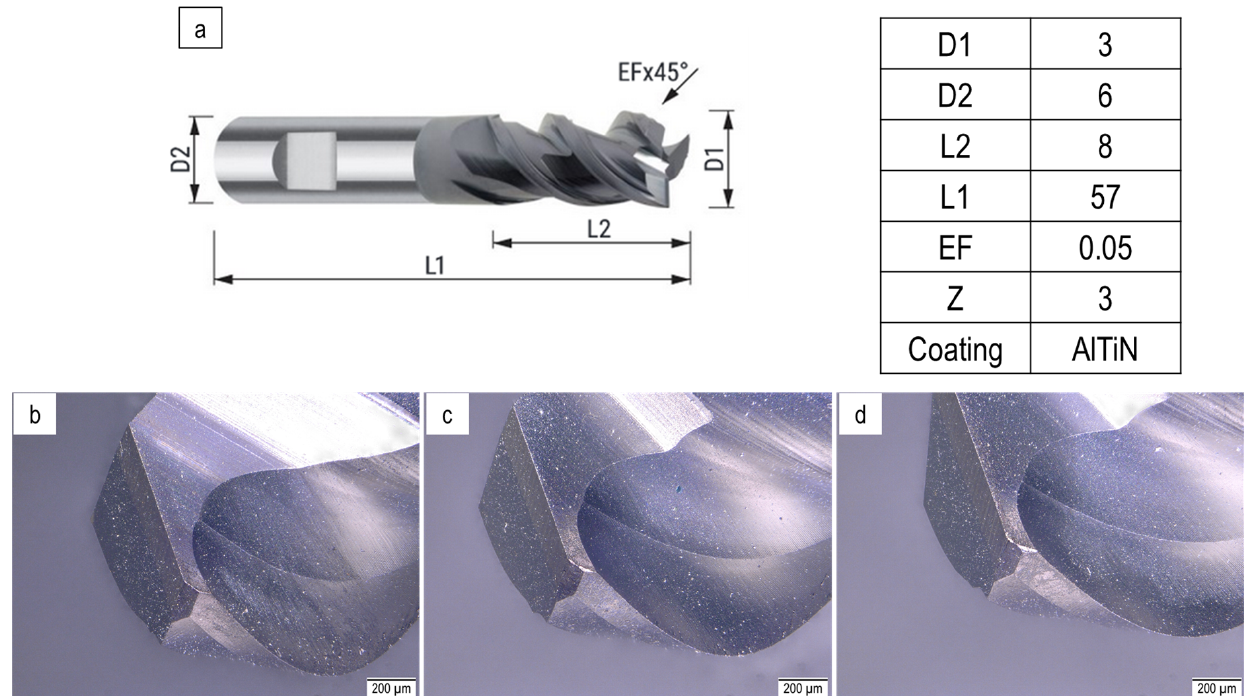
Figure 2. ( a ) Experimental setup. ( b ) Illustration of different